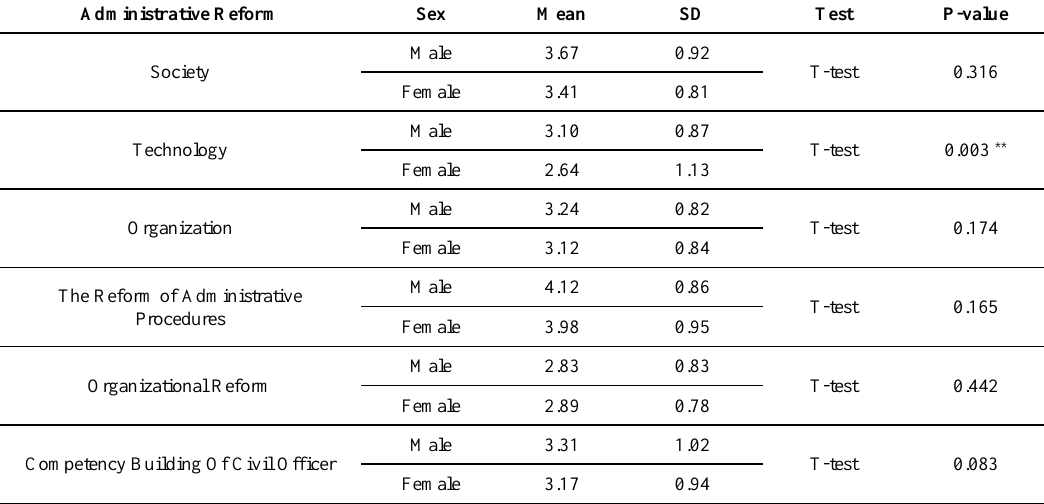
Table 4. Digital transformation and administrative reform by gender